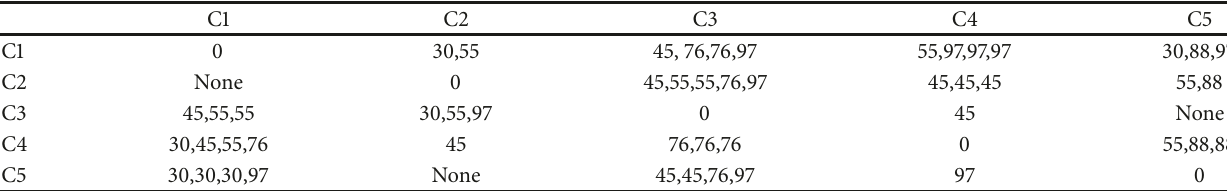
Table 4: Country A’s potential attack